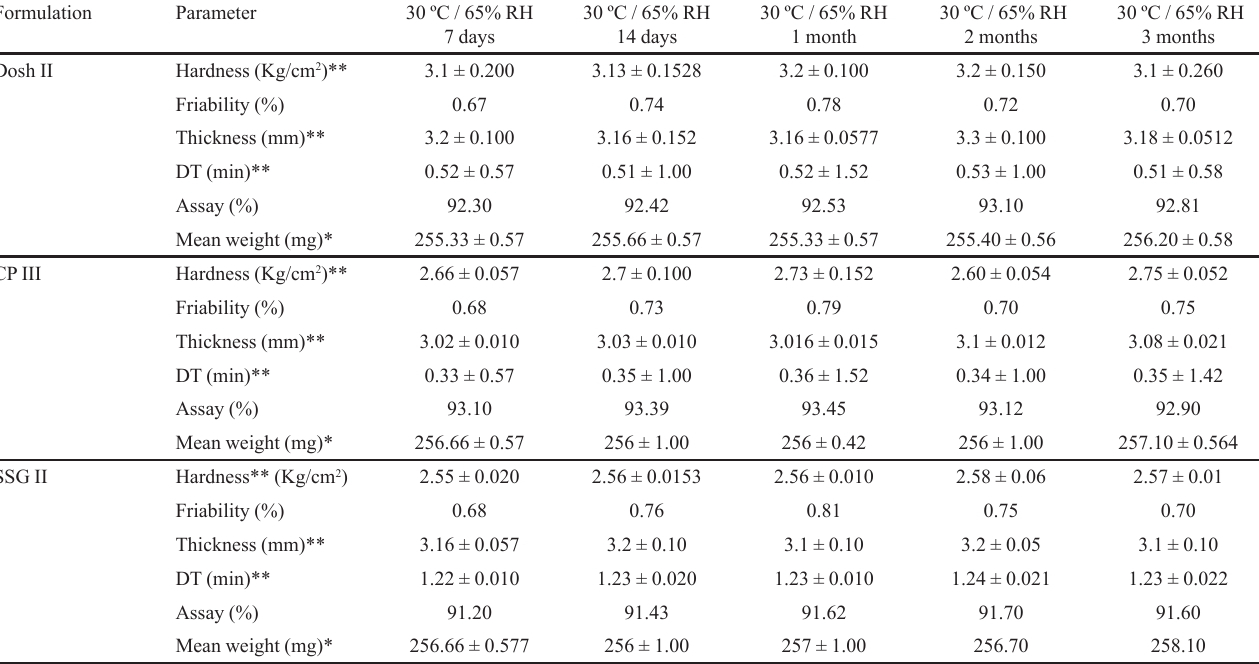
TABLE VI - Stability Testing-i) 40 ± 2 o C and RH 75 % ± 5%